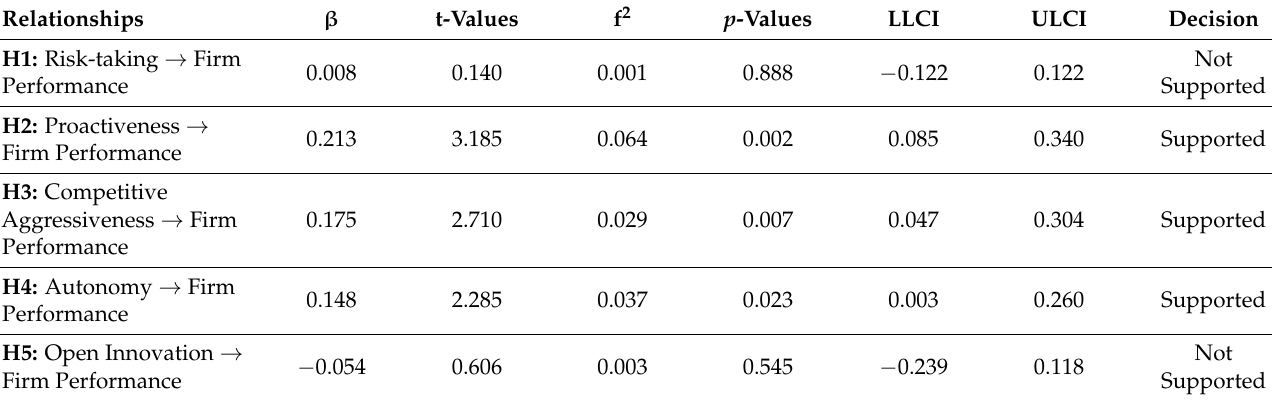
Table 6. Hypothesis